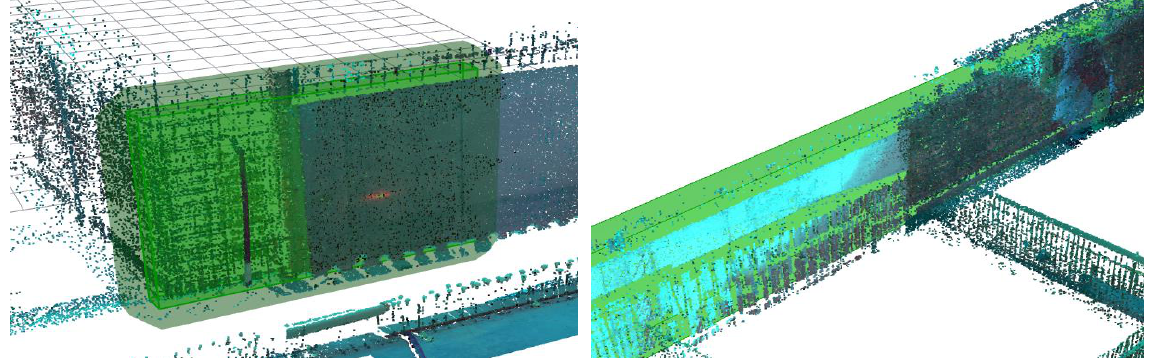
Figure 4c: Mixed state occurrence errors: Walls with parts in different states are inherently prone to misclassification.